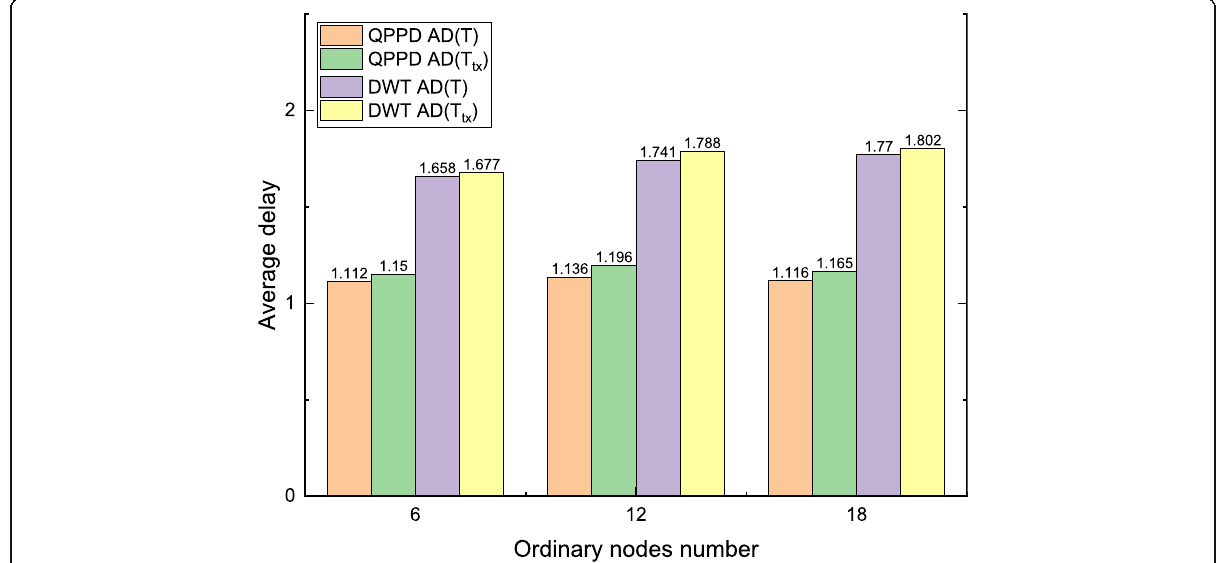
Fig. 44 The total volume of data randomly changes from 0 to 3; the average delay of high priority